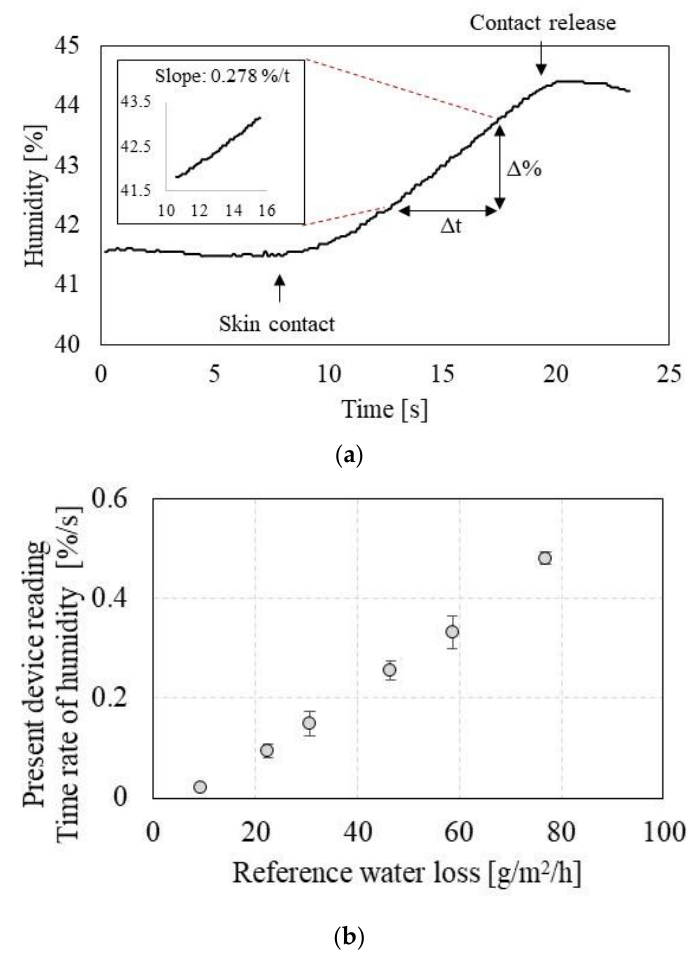
Figure 3. Transepidermal Water Loss (TEWL) measurement characterization, where the truncated hollow cone (THC) probe is in contact with the semipermeable membrane of the artificial skin: ( a ) the relative humidity profile over time; ( b ) calibration profile indicating the time rate of humidity depending on the reference water loss from the artificial skin.